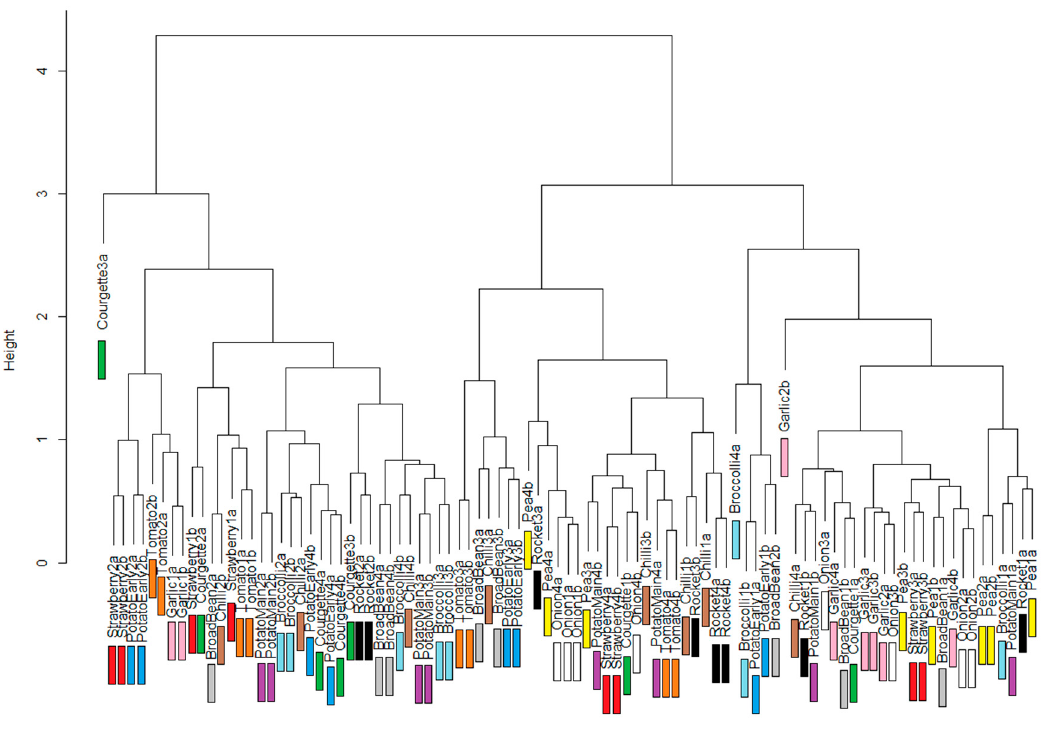
Figure 4. Dendrogram produced for the “no preprocessing”option on vegetable plot spectra.